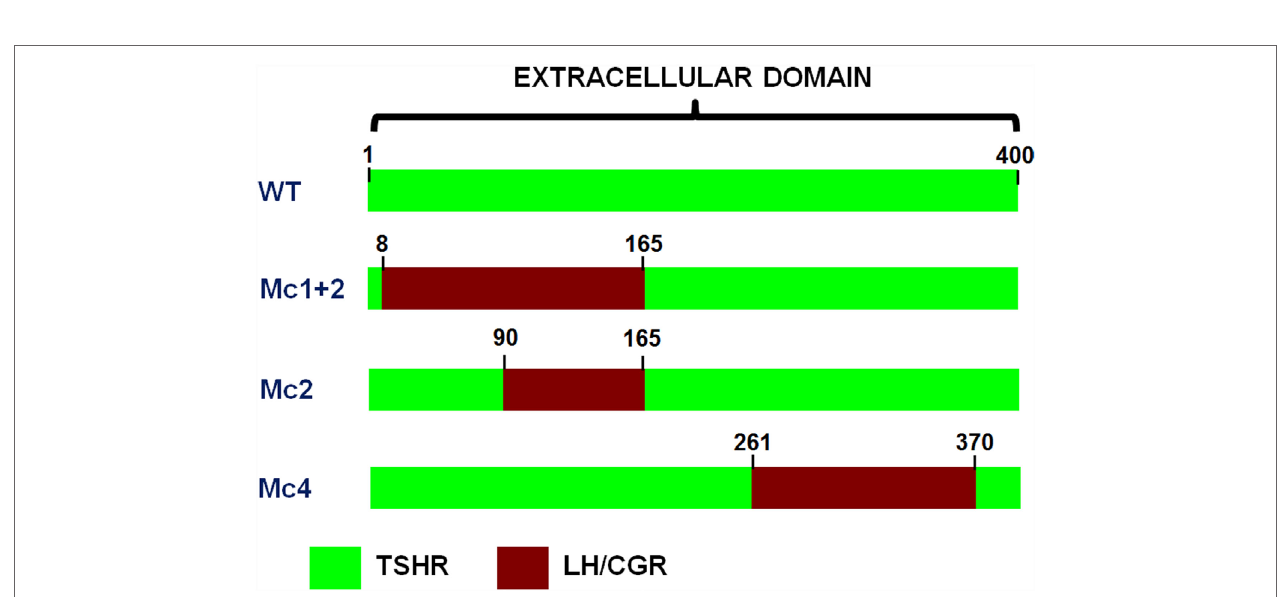
FiGURe 3 | Schematic representations of the extracellular regions of the three chimeric TSHR–LH/CGR mutants . The Mc1 + 2, Mc2, and Mc4 chimera receptors. Green, human TSHR sequence (WT); red, homologous regions of the rat LH/CGR that were used to substitute for the deleted TSHR sequences. The numbers assigned to the amino acids are determined by counting from the methionine start site.